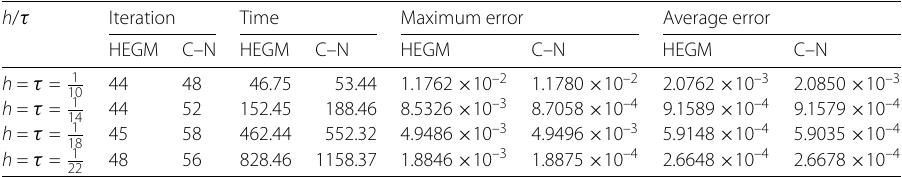
Table 6 Comparison between C–N high-order finite difference method and HEGM for Example 3 when γ = 0.1